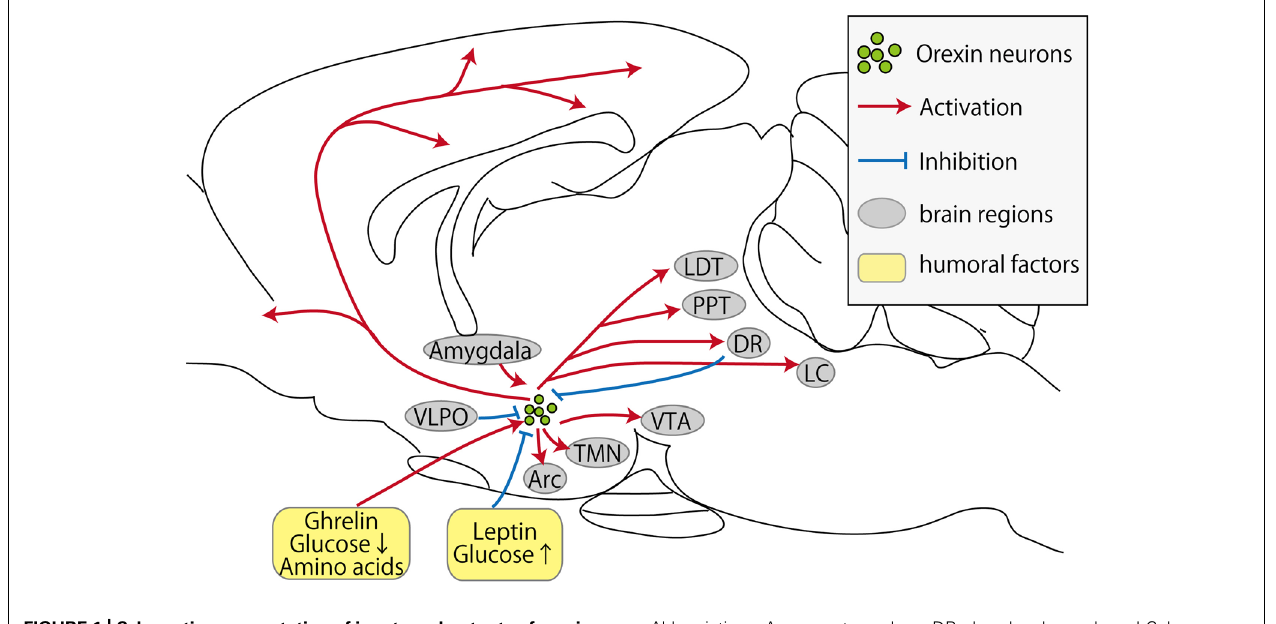
FIGURE 1 | Schematic representation of inputs and outputs of orexin neurons. Orexin neurons are found only in the lateral hypothalamic area but project throughout the entire central nervous system. Red arrows show excitatory projections, while blue lines show inhibitory projections.